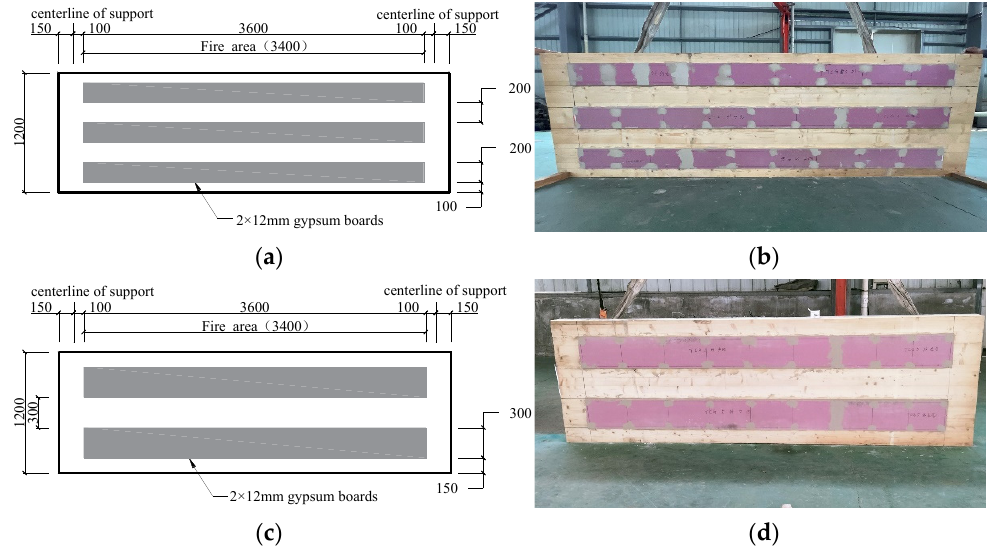
Figure 2. The forms of protection: ( a ) schematic diagram of TCG2; ( b ) photo of TCG2; ( c ) schematic diagram of TCG3; and ( d ) photo of TCG3 (units: mm).